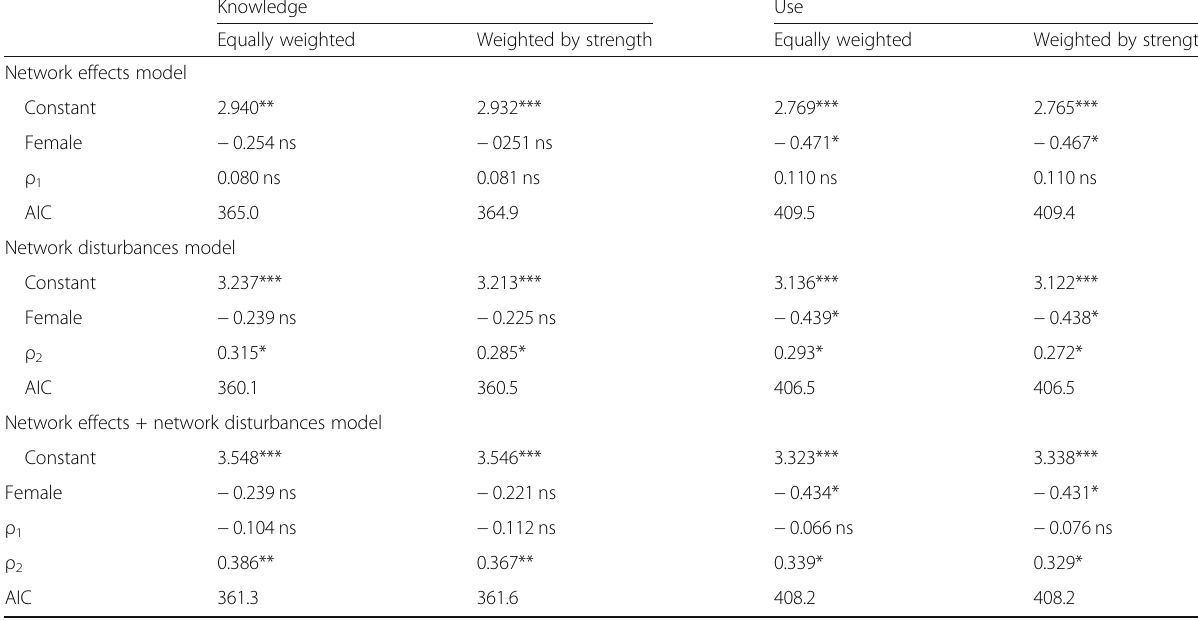
Table 7 Peer influence models